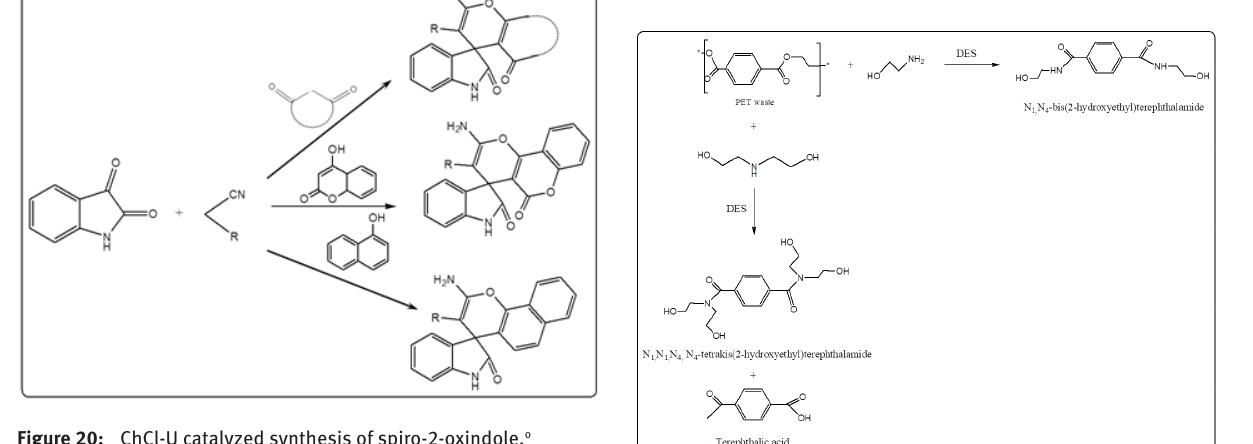
Figure 20: ChCl-U catalyzed synthesis of spiro-2-oxindole. o o See Azizi et al. [81] for detailed reaction components and conditions.